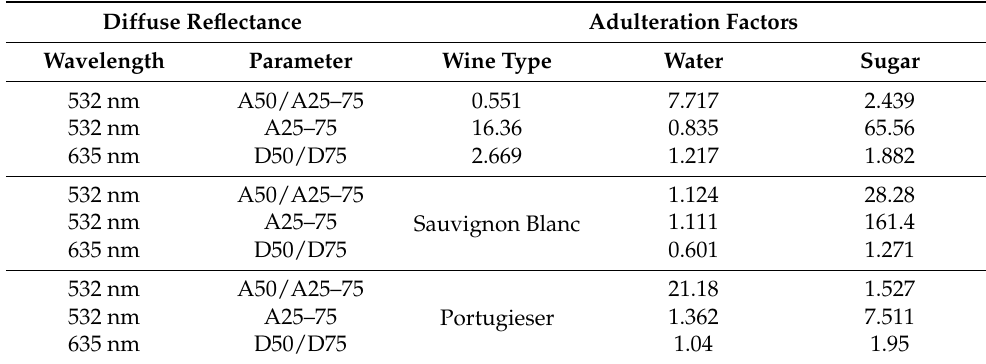
Table 5. ANOVA F-scores for the most sensitive diffuse reflectance